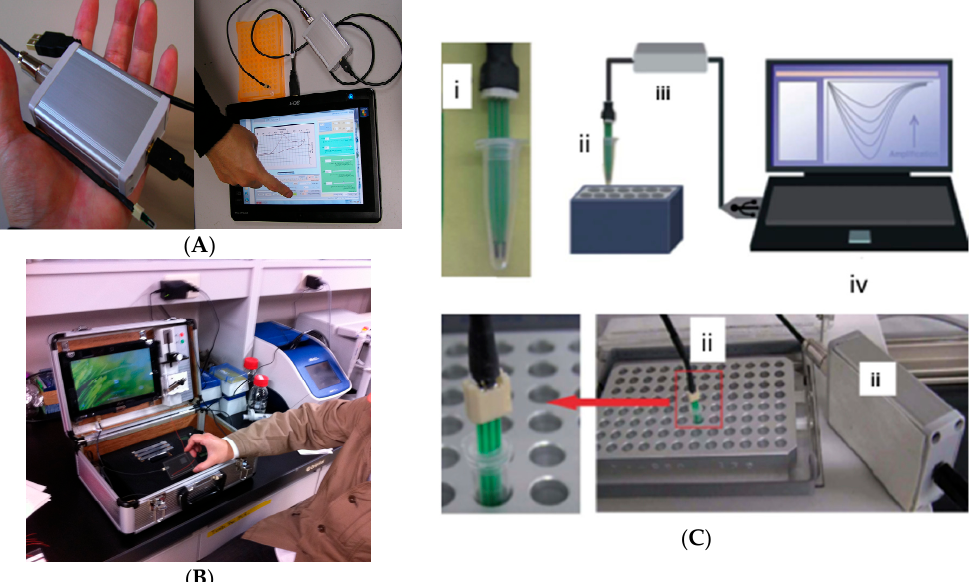
Figure 5. Portable electrochemical devices used with disposable electrochemical printed (DEP) chips: Handheld potentiostat, operated by a simple PC or tablet ( A ); conveniently fitted in a small